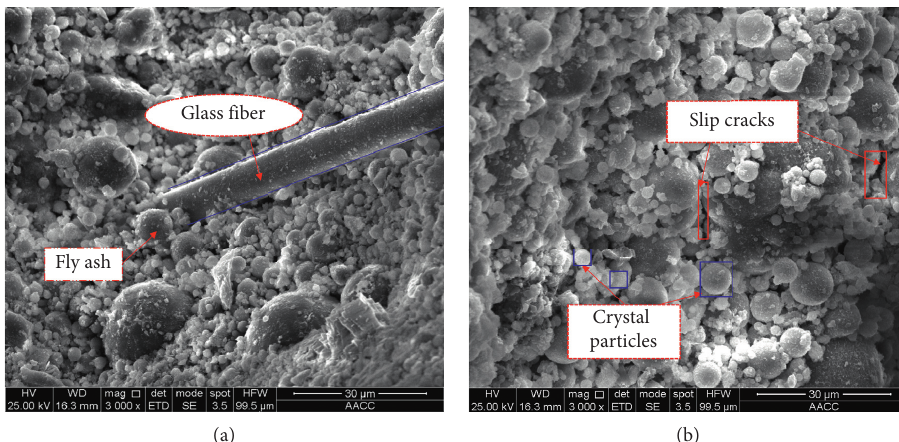
Figure 13: The microstructure of SCPB specimens with and without doped glass fibers at a 14d curing age. (a) With glass fibers. (b) Without glass fibers.